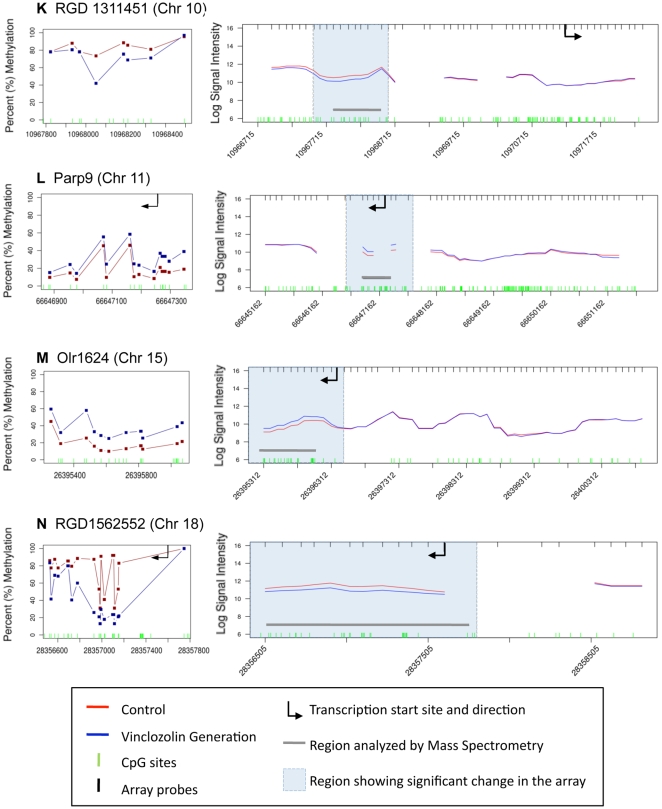
Refer to 
Figure 2
 Legend.